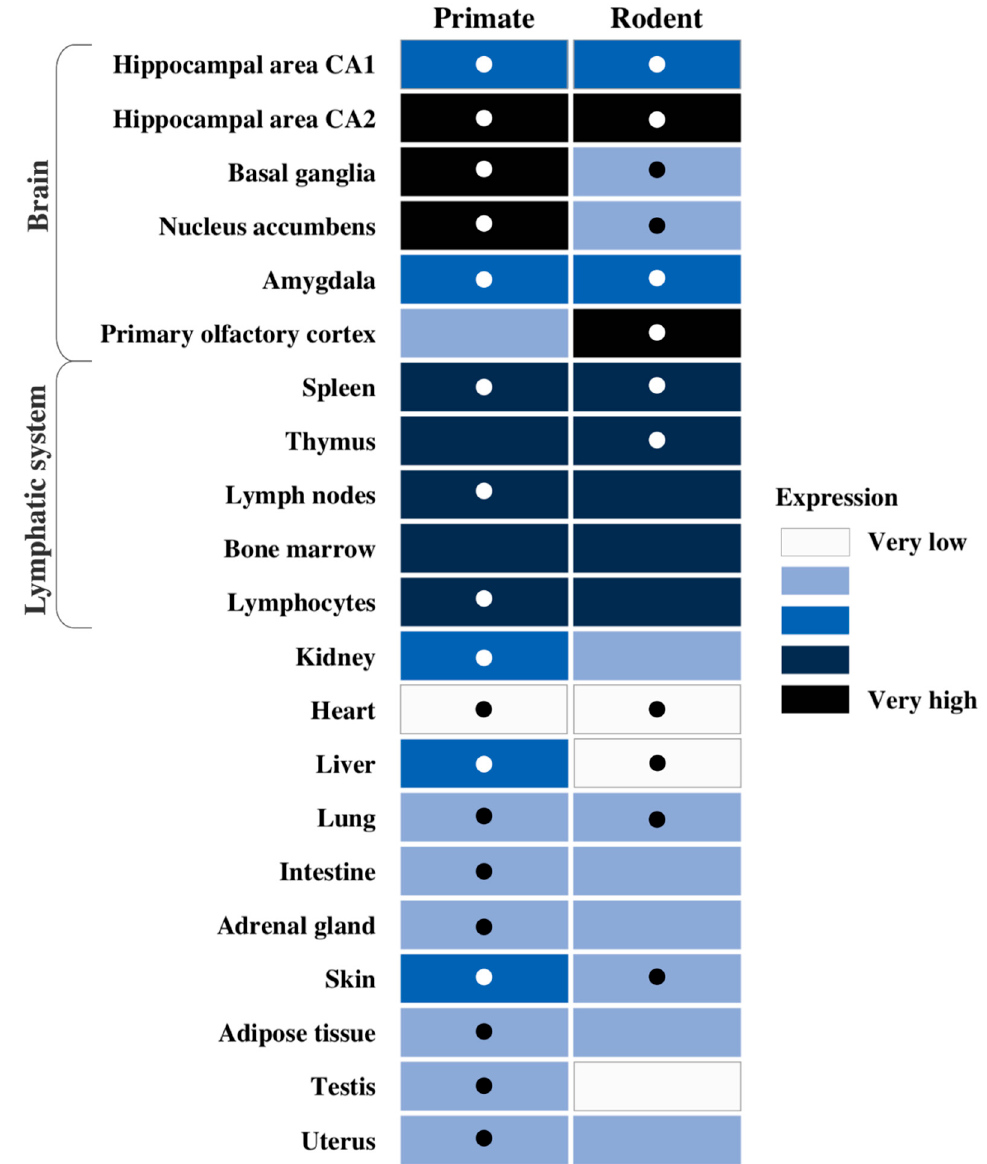
Figure 2. Reported tissue expression of RGS14 in adult primate and rodent. Cell shading indicates RGS14 mRNA expression across tissues. Dot indicates positive RGS14 protein expression data. Data were aggregated from the following sources: ProteomicsDB [49], Mouse Gene Expression Database (GXD) [50], Global Proteome Machine Database (GPMDB) [51], Allen Human Brain Atlas [52], Allen Mouse Brain Atlas [53], Human Protein Atlas [54], Ensembl [55], Evans et al. 2014 [27], Squires et al. 2018 [26], and Foster et al. 2021 [56]. Expression levels for mRNA were compiled from the sources cited above and defined in a relative manner from available data for each species ( M. musculus and R. norvegicus for rodent, H. sapiens and M. mulatta for primate).